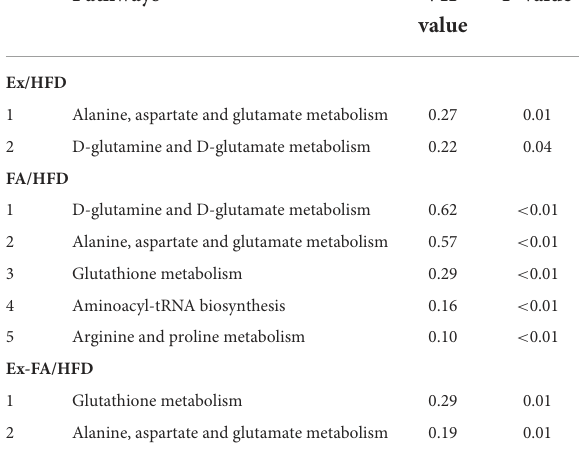
TABLE 2 KEGG topological